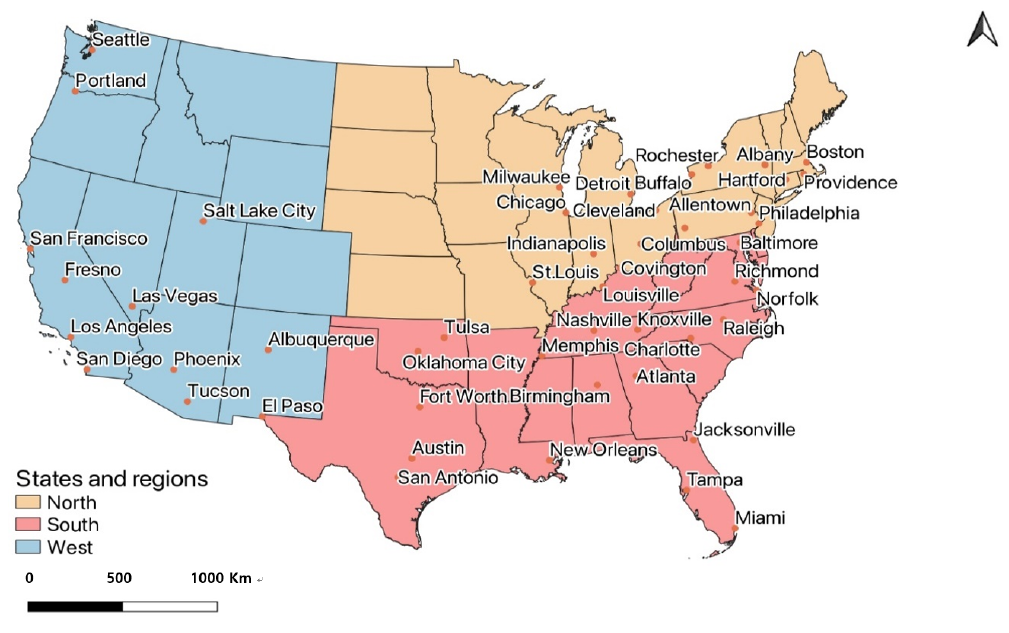
Figure 1. Location of 49 cities in the study area.